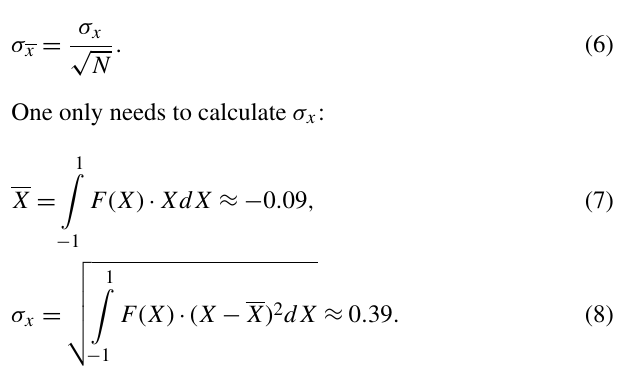
Figure 10. F ( X ): probability density function of the bias ( X ) be- tween the classified water ratio ( X 1 ) and real water ratio ( X 0 ) in a shoreline